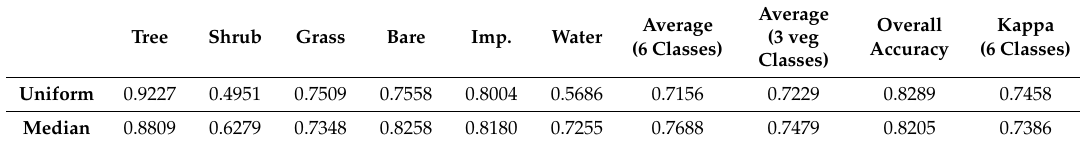
Table 15. Accuracy (uniform and median weights, Oregon—6 classes).